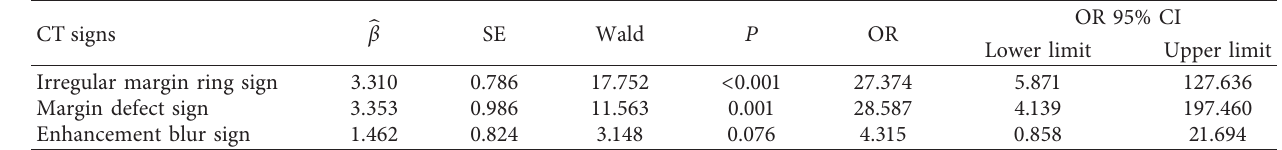
Figure 5: Low-density nodule ( ∗ ) in the left lobe of the thyroid gland, in a female, 72 years old. (a) Plain scan and (b) enhancement scan, which show that the lesion is clear after enhancement, and the difference between the density of the thyroid nodule and the normal thyroid is enlarged. At the same time, the edge of the thyroid gland was continuous ( ↑ ), pathologically confirmed as nodular goiter. Table 3: Multivariate regression analysis of three signs.